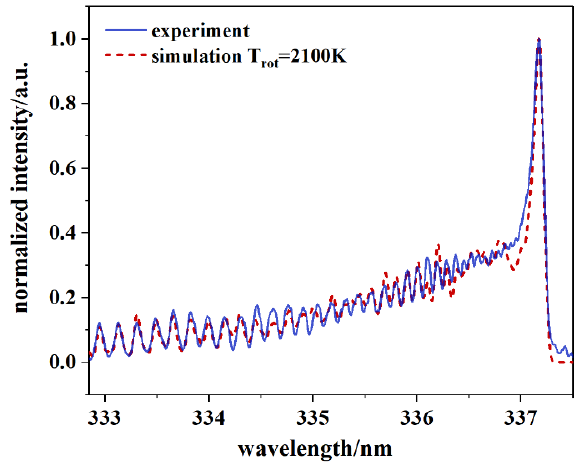
Figure 8. The experimental and simulated emission spectrum of N 2 in arc discharge with a gap distance of 2 cm.